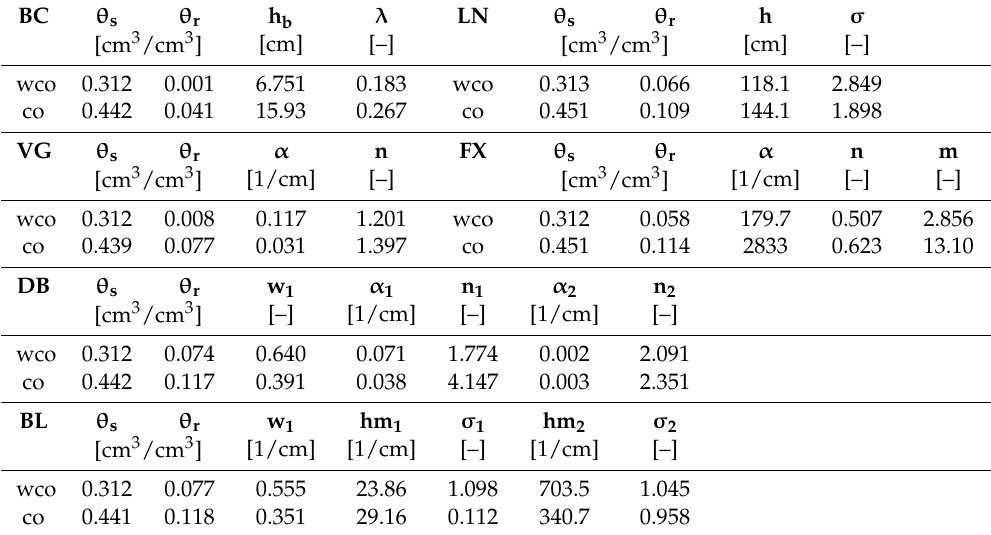
Table 11. Fitted soil water retention curve parameters of the boulder marl without compost (wco) and with compost (co): BC model [18], VG model [9], FX model [19], LN model [20], DB model [21], and BL model [22].